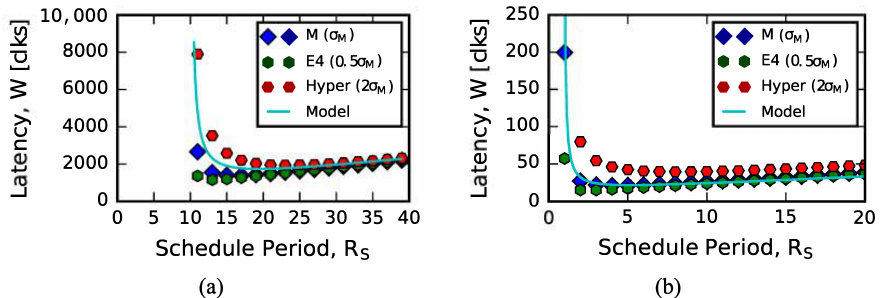
Figure 22. Discrete-event simulation of latency vs. schedule period. This is for two sets of parameters with varied arrival distributions. The curve is analytically generated from (18) and the points are empirically measured via the discrete-event simulation. ( a ) C = 10, N = 100, S = 100, OL = 0.5 ( b ) C = 4, N = 8, S = 4, OL =